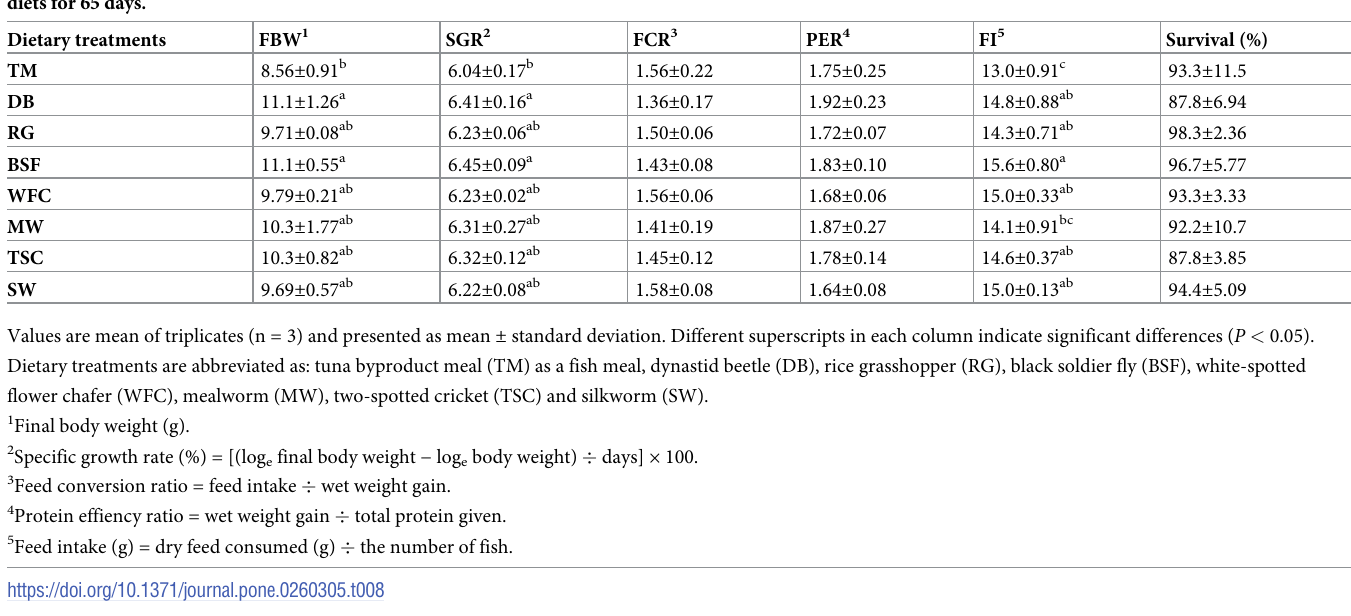
Values are mean of duplicates (n = 2) and presented as mean ± standard deviation. Tested insect meals are abbreviated as: dynastid beetle (DB), rice grasshopper (RG), black soldier fly (BSF), white-spotted flower chafer (WFC), mealworm (MW), two- spotted cricket (TSC) and silkworm (SW).